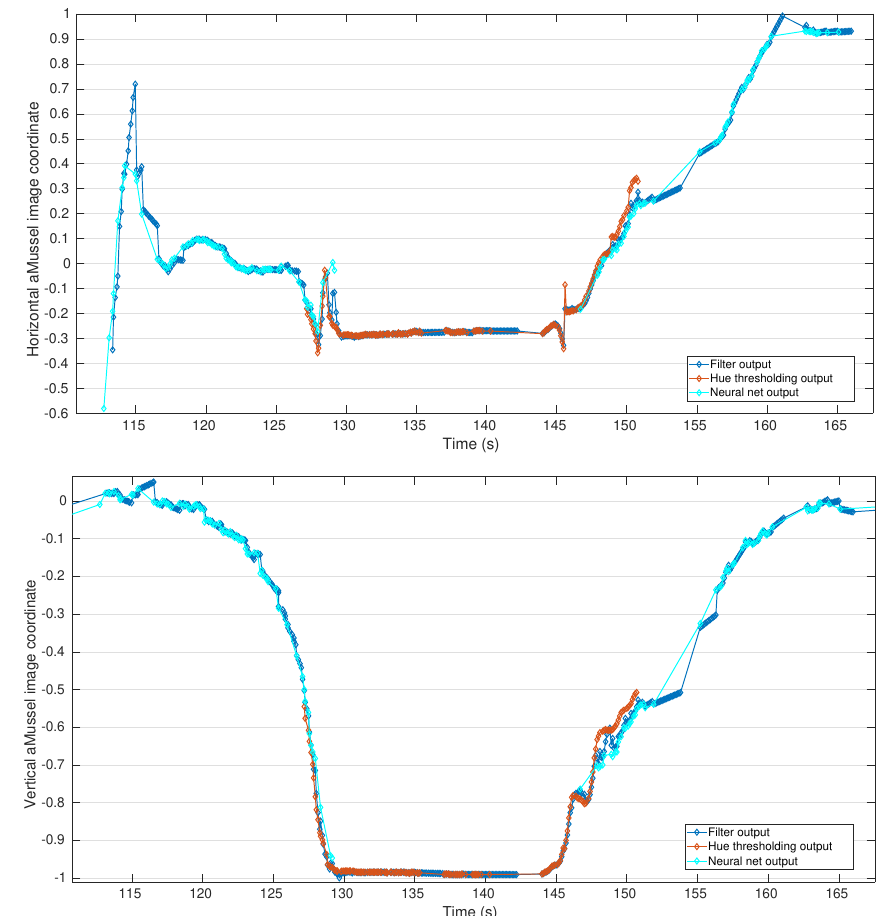
Figure 16. Example of filter inputs and output during a single docking, with markers denoting individual measurements where received, horizontal ( above ) and vertical ( below